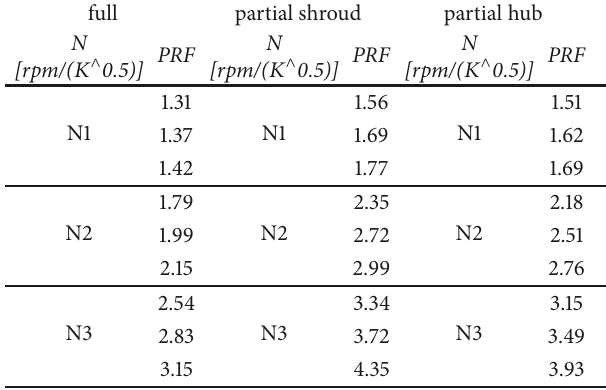
Table 4: Set of tested cases in full, partial shroud, and partial hub admission.